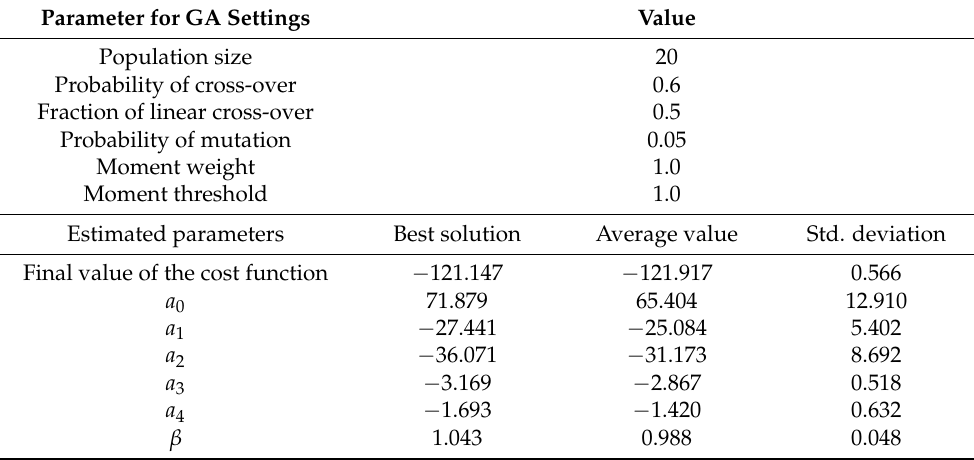
Table 7. Summary of the LRM for the fatigue life of the spruce